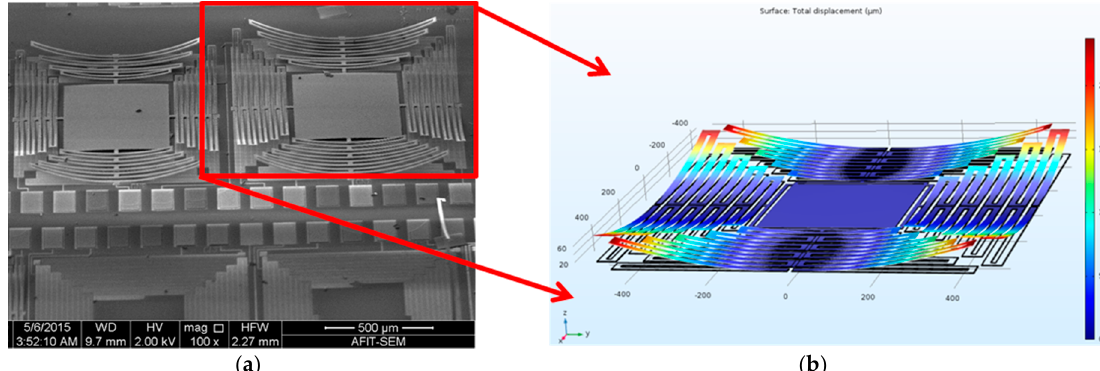
Figure 3. An SEM image of the electrothermal design as fabricated in PolyMUMPs is shown in ( a ) which shows no physical upward deflection; ( b ) shows the Comsol model of the identical structure also revealing no upward deflection.